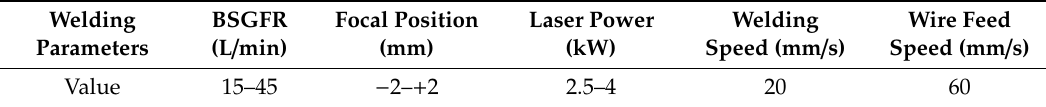
Table 3. Process Table 3. Process parameters.